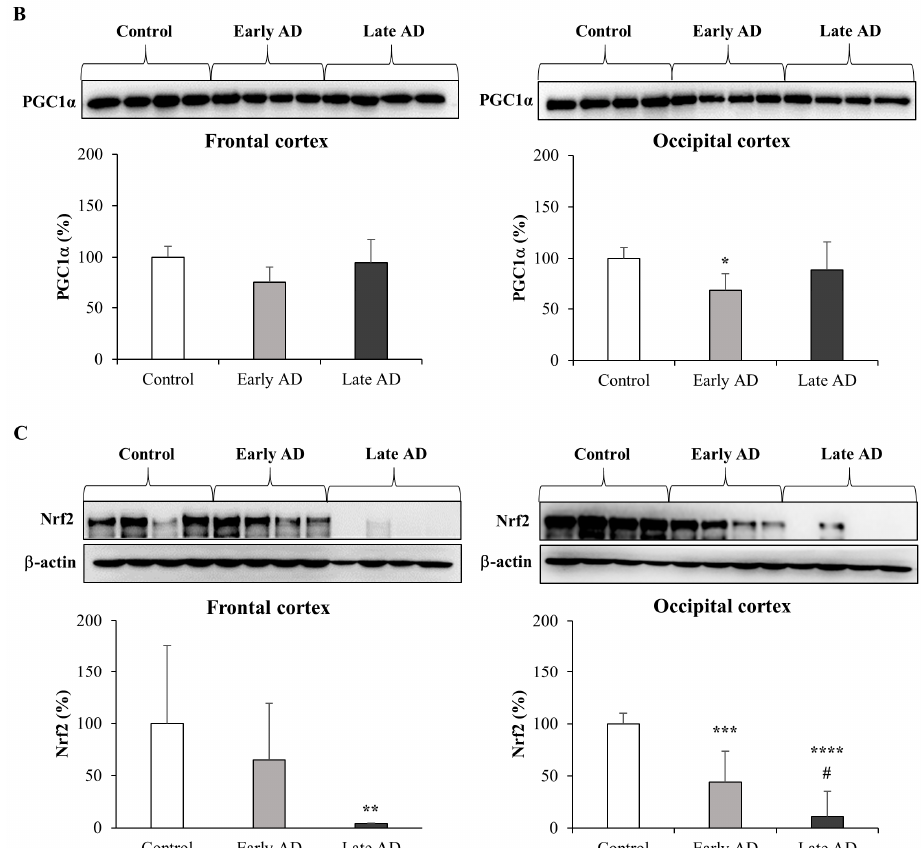
Figure 8. Protein levels of SIRT1 ( A ), PGC1 α ( B ), and Nrf2 ( C ) in brain samples. Protein levels were analyzed by Western blotting in all frontal and occipital cortex specimens of AD (Early AD: n = 6; Late AD: n = 8) and of healthy subjects (Control: n = 9). Representative blots are shown. SIRT1 and Nrf2 densitometric measurements were normalized against the corresponding β -actin levels. SIRT1, PGC1 α , and Nrf2 densitometric measurements of the protein levels of all AD specimens are expressed as percentage of control value. * p < 0.05, ** p < 0.01, *** p < 0.001, **** p < 0.0001 vs. control; # p < 0.05 vs. Early AD.